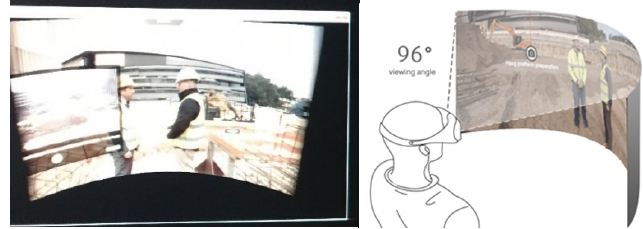
Figure 6. Leading a team of internal and external parties for developing the modules from fieldwork to digital lab production. ( a ) fieldwork for production planning in 2017; and ( b ) capturing 360 footages, including some patterns’ logo involved in the production.